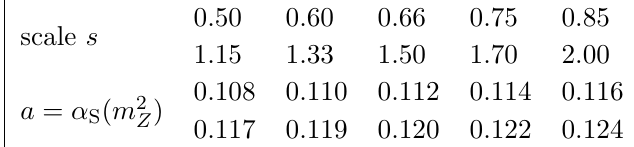
Figure 7 . The reweighting factors for a low- and a high- t lead ( N em ) bin are shown in the upper (lower) row. The projections on the a - s plane show the ratio between neural-net-predicted and NN true reweighting factors, w k = w k . The predicted factor was omitted in the training of the b h i h i b corresponding neural net. The clipped corners in the ratio projection for the t lead bins and the N em = 1 bin are due to the ratio being beyond the scale of 2 % for a = 0 : 124 and s = 0 : 25. (cid:6)